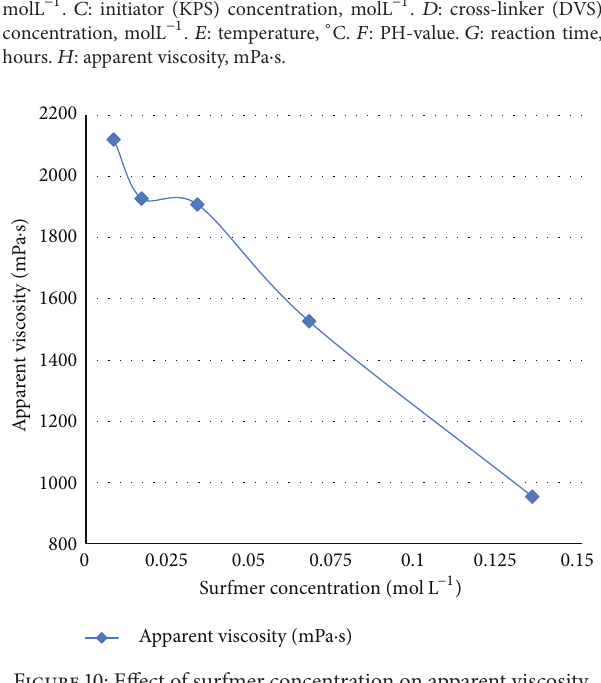
which reduces the tendency for intermolecular association, so solution viscosity decreases [41].